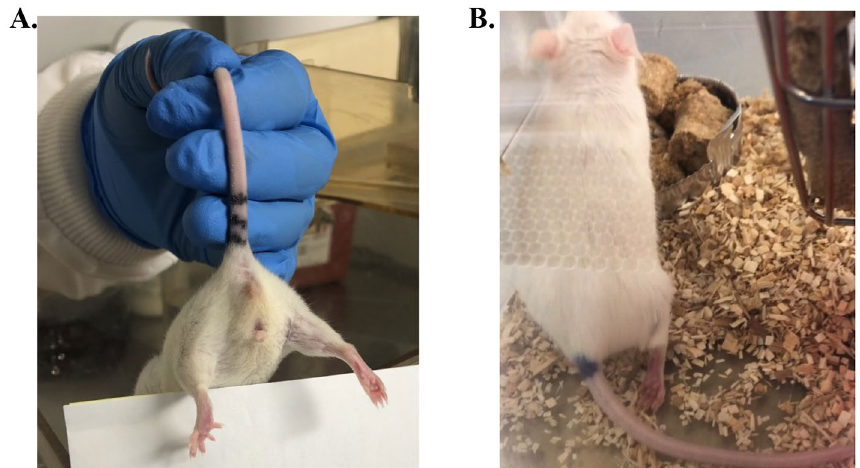
Figure 2. Representative images of mice with ( A ) a foot of closed digits, or ( B ) tarsal extension and dragging foot on the leg receiving injection. Animals here received scores of ( A ) 1 and ( B ) 3 for the foot/leg function parameter.